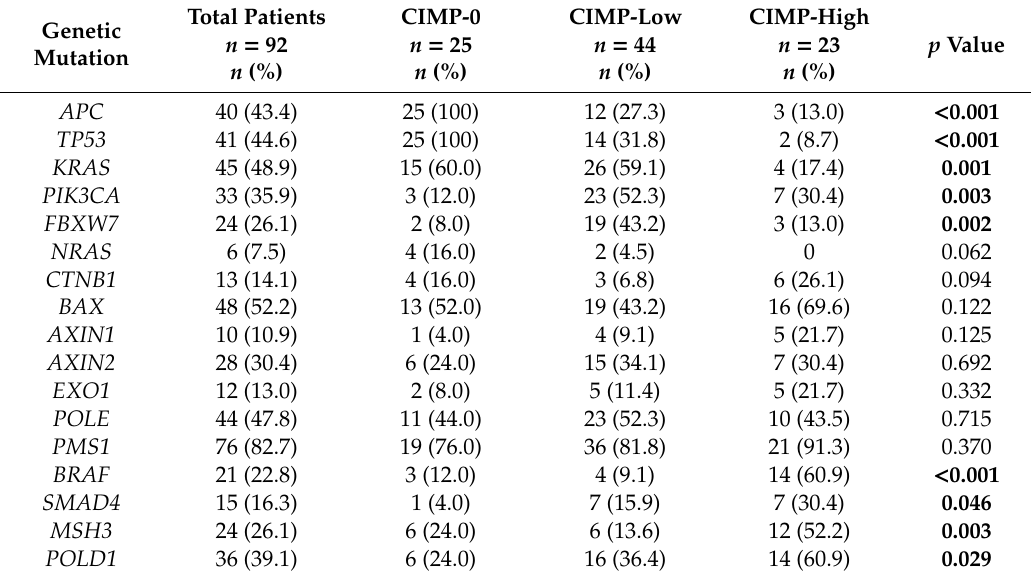
Table 2. Molecular signatures of MSI-high CRC classified by CIMP